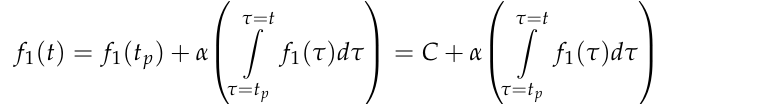
Fitting curve ( D = -11.477 D y 2 ) Figure 6. Deviation of α versus the undershoot factor ( D y 2 ) and the fitted curve. The deviations ( D x ) of the base curve parameters ( A , B , α , or β ) are defined as Equa- tion (7), where x cal and x std are the parameters computed by the proposed and standard recommended methods, respectively.